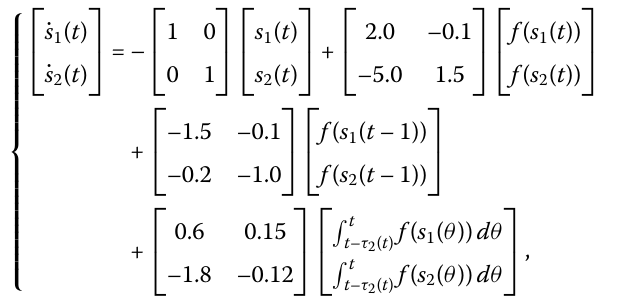
Example 4.1 Consider the isolated node with both discrete and distributed delays: